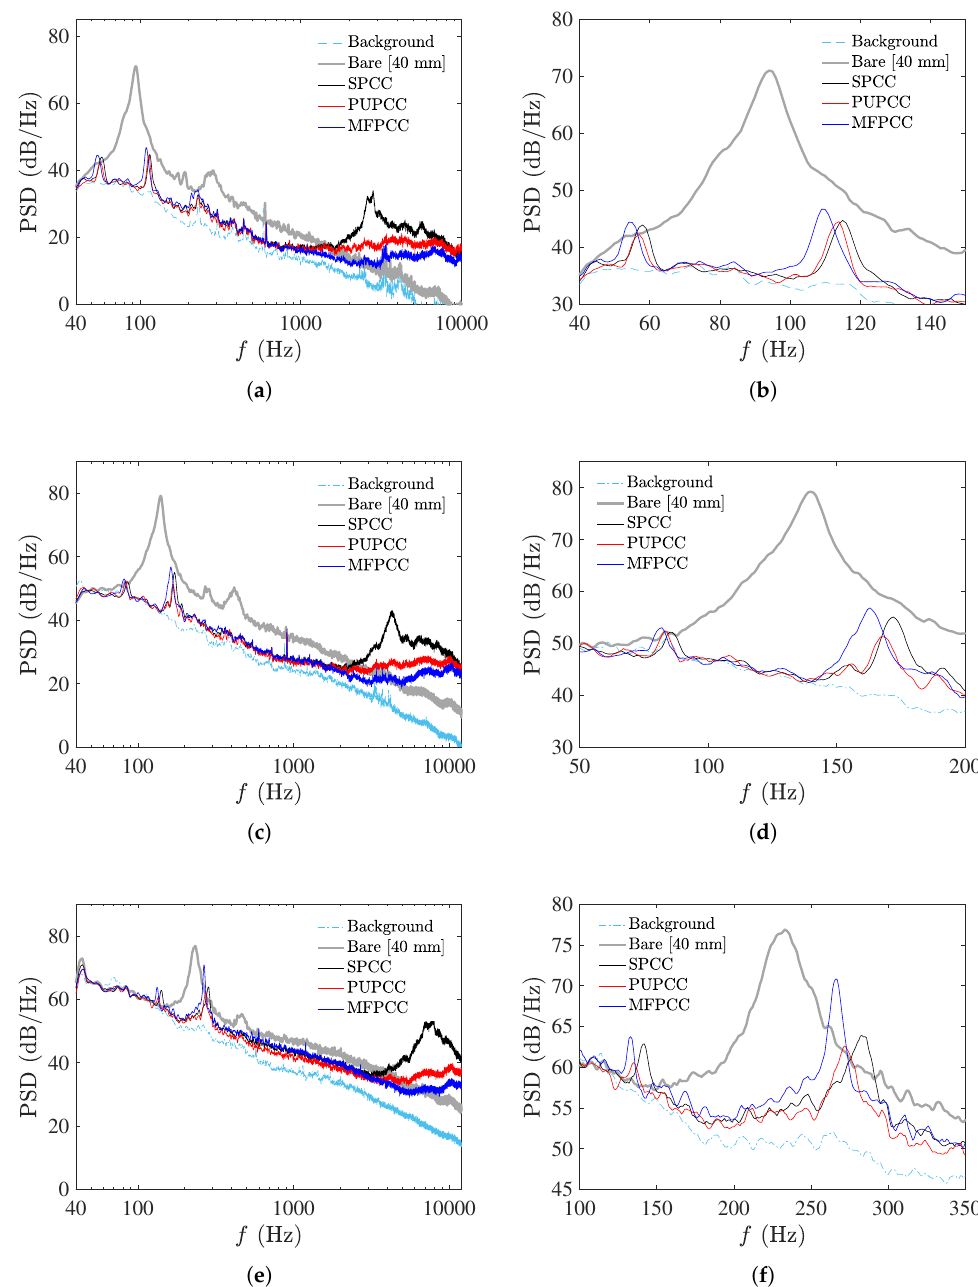
Figure 7. PSD of the PCC’s ( left ) and magnification within the tonal noise frequency range ( right ) at ( a , b ) U = 20 m/s, ( c , d ) U = 30 m/s and ( e , f ) U = 50